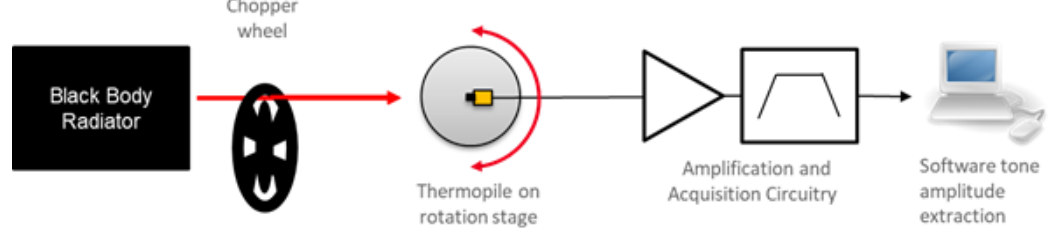
Figure 6. Schematic representation of the measurement setup employed for characterizing the sensor responsivity as a function of the radiation incident